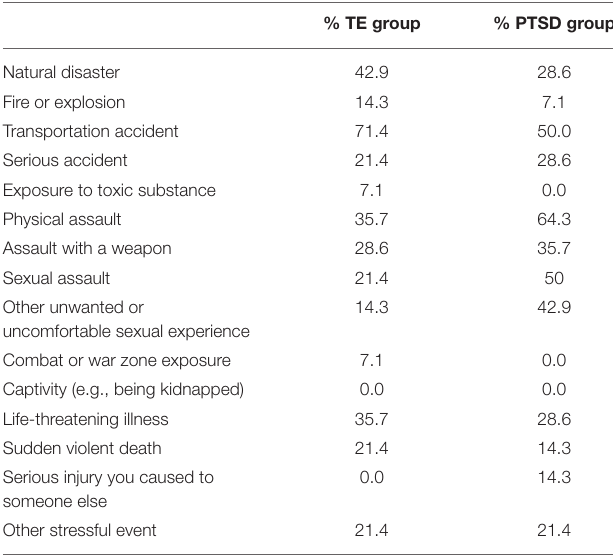
TABLE 1 | Percent of trauma-exposed (TE) and PTSD groups witnessing or experiencing different types of traumatic